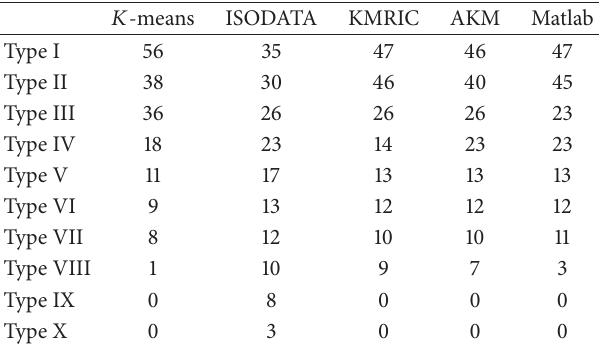
Table 2: Clustering method comparisons under Iris